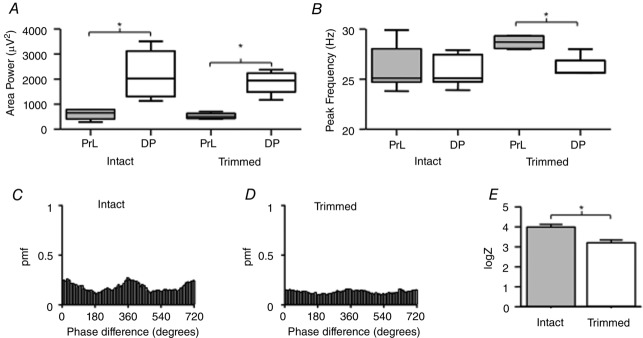
Subregional differences in network oscillations in trimmed PrL and DP slicesGroup data boxplots of the area power (A) and peak frequency (B) of network oscillations in the PrL and DP regions of intact and trimmed slices. The area power difference remained significant between PrL and DP regions after the two regions were anatomically separated with a cut across the IL (Intact: P < 0.05, Mann–Whitney rank sum test, nPrL = 5, nDP = 5, Trimmed: P < 0.05, Mann–Whitney rank sum test, nPrL = 4, nDP = 4). However, significant changes occurred in the peak frequency of network oscillations in the trimmed slices, with the PrL oscillating significantly faster than the DP (Intact: P > 0.05, Mann–Whitney rank sum test, nPrL = 5, nDP = 5, Trimmed: P < 0.05, Mann–Whitney rank sum test, nPrL = 4, nDP = 4). C and D, representative phase-coherence histograms (bin size: 10 deg) between layer V–VI oscillations recorded in the PrL and DP regions of intact (C) and trimmed (D) slices (2 cycles; 0–720 deg). E, group data barplot of the logZ values, showing that phase coherence between PrL and DP was significantly stronger in the intact slices (logZ values, intact vs. trimmed, P < 0.05, Student's unpaired t test, nintact = 5, ntrimmed = 4) *Significant difference.